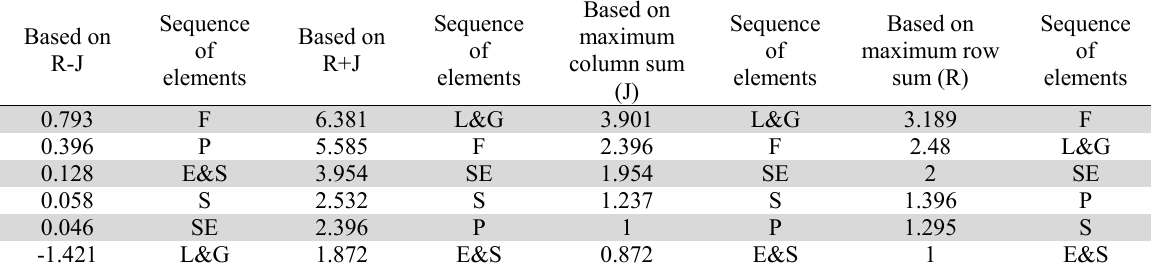
Sequence of influence of dimensions affecting knowledge management evaluation in Tehran Petrochemical Industries Based